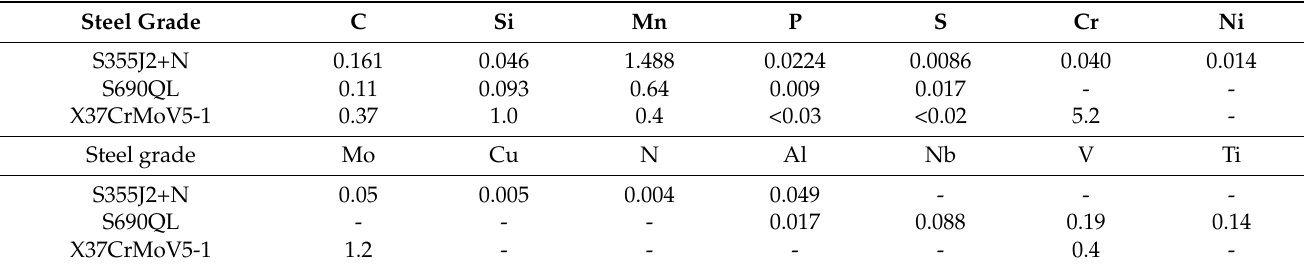
Table 1. Comparison of the chemical composition of the S355J2+N, S690QL, and X37CrMoV5-1 steel grades (weight %).